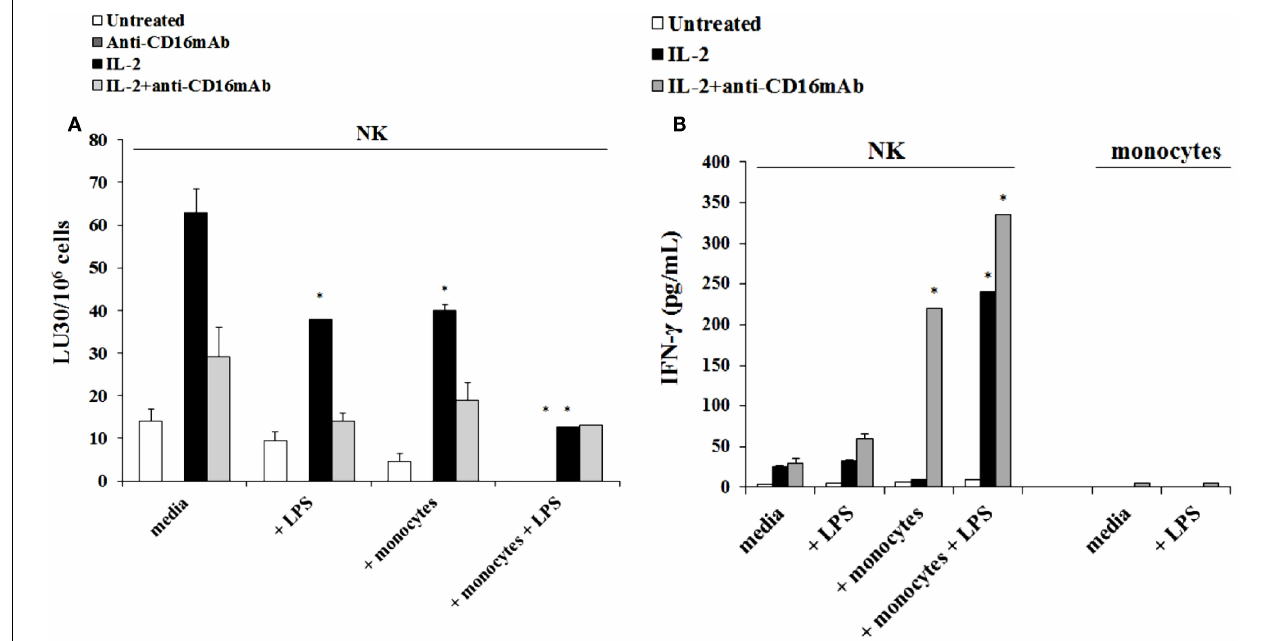
FIGURE 7 | Induction of split anergy mediated by LPS was observed in Human NK cells which resulted in a loss of their cytotoxic function but gained the ability to secrete high levels of IFN- γ , especially in the presence of autologous monocytes . Human NK cells were purified from healthy donors and were left untreated or treated with IL-2 (1000U/mL), anti-CD16mAb (3 µ g/mL), or the combination of IL-2 (1000U/mL) and anti-CD16mAb (3 µ g/mL) in the presence or absence of LPS (20ng/mL) and autologous monocytes (NK cell:monocytes, 1:1) for 24–48h. Afterward, the cytotoxicity against OSCSCs was assessed using a standard 4h 51 Chromium release assay. Percent cytotoxicity was obtained at different effector to target